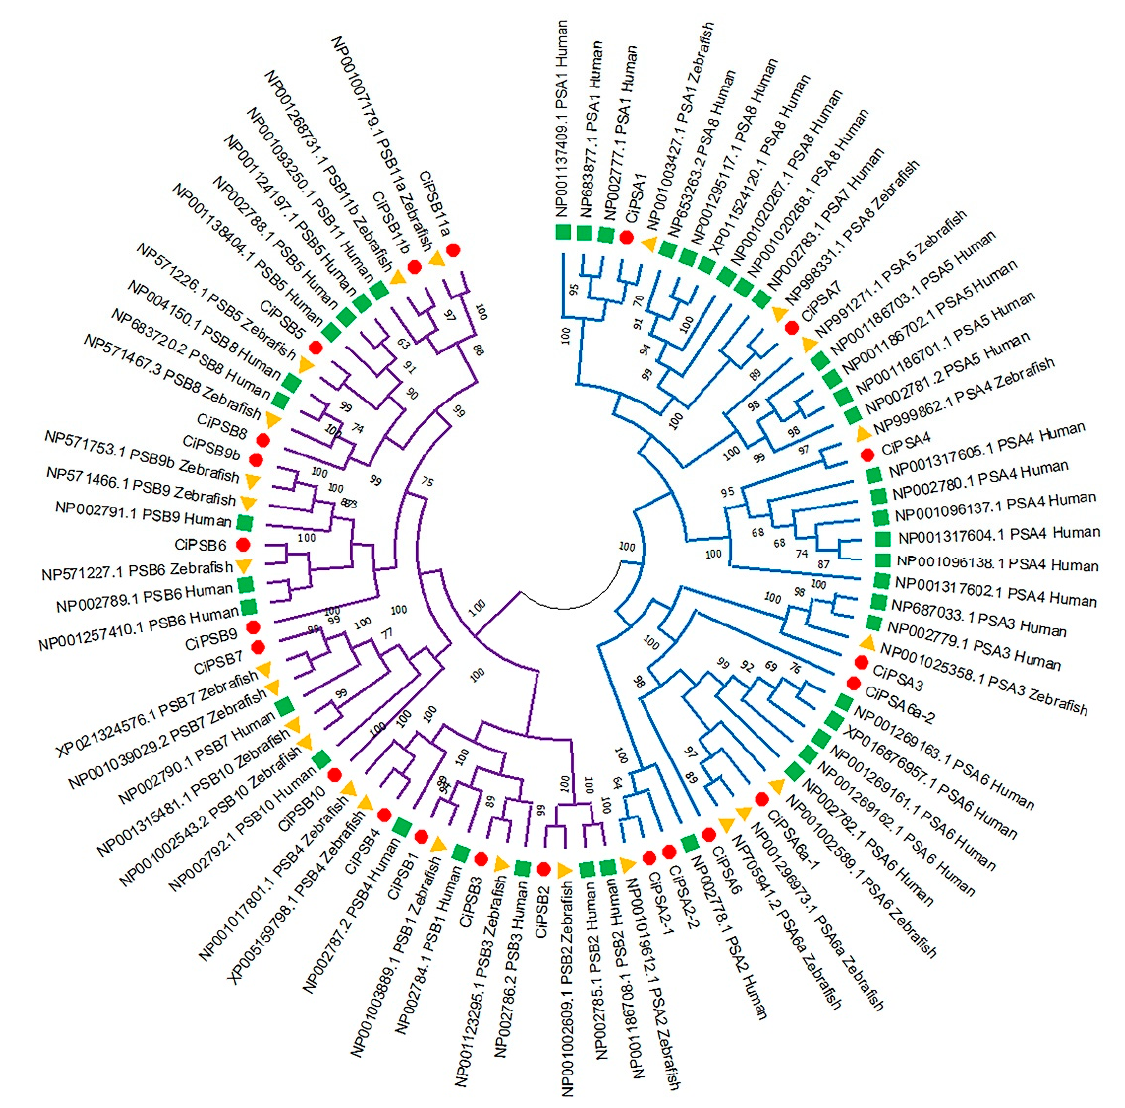
Figure 1. Phylogenetic tree analysis of the CiPS gene family members in grass carp.